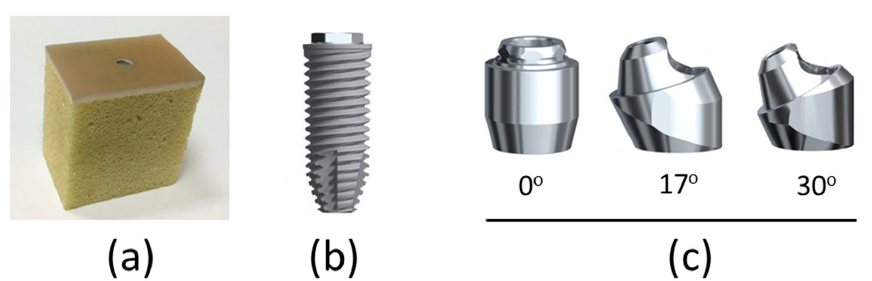
Figure 1. ( a ) Artificial foam bone specimen; ( b ) NobelSpeedy Groovy; ( c ) Multiunit abutments.